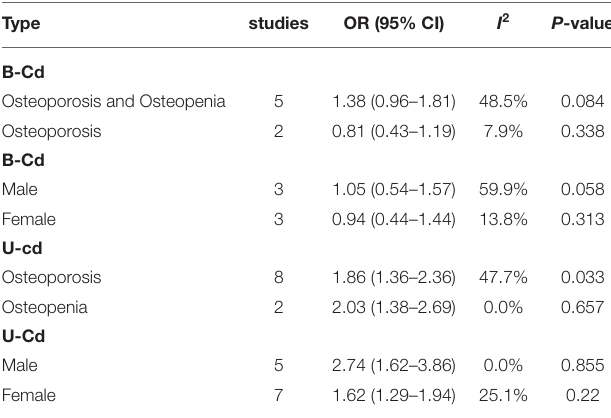
TABLE 3 | Subgroup analysis to investigate differences between studies included in